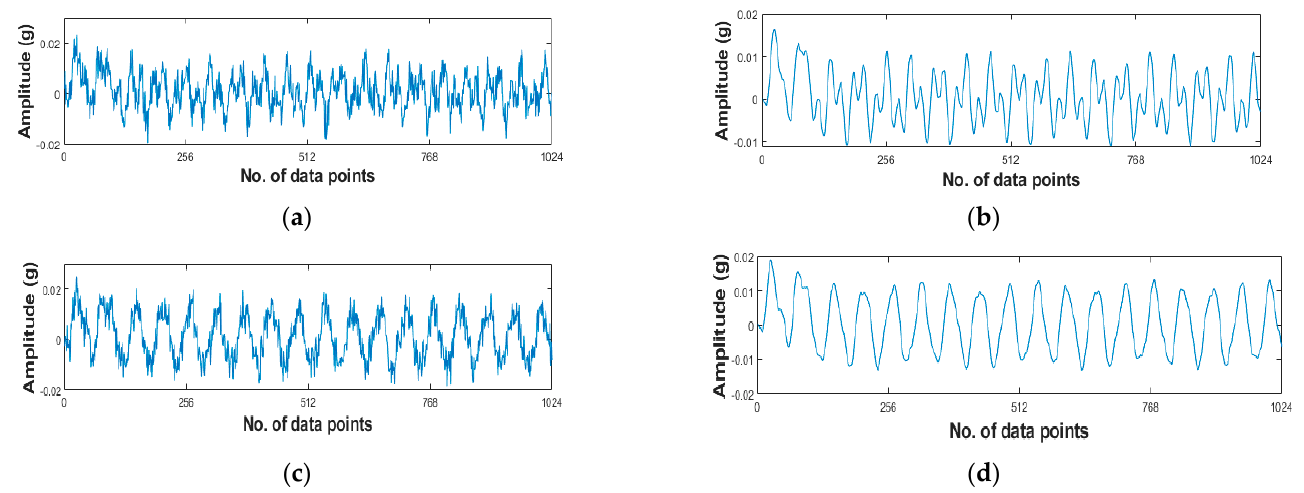
Figure 5. Vibration response of composite plates. ( a ) Experimental response of the laminated composite plate. ( b ) Finite element response of the laminated composite plate. ( c ) Experimental response of the delaminated composite plate. ( d ) Finite element response of the delaminated composite plate